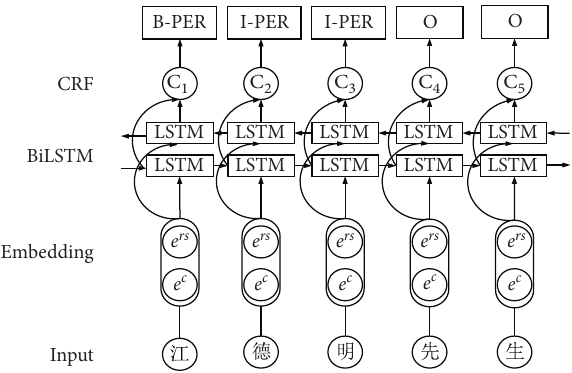
Figure 2: MAF-CNER model network structure.